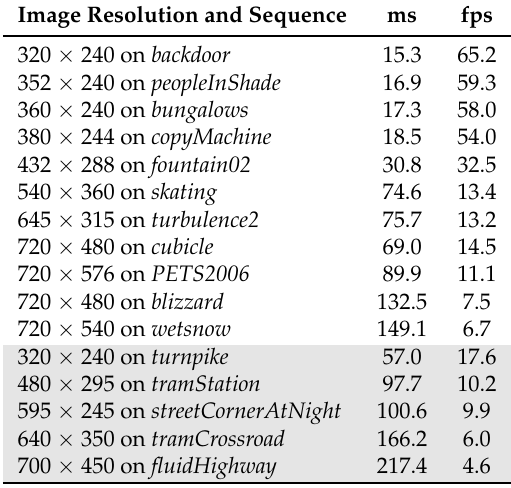
Table 4. Average Computation Times on Selected Sequences from